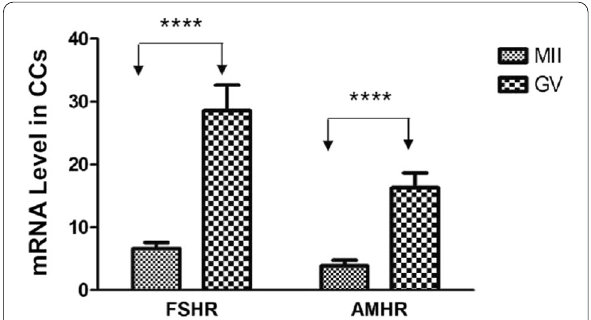
Fig. 1 The gene expressions of FSHR and AMHR2 between MII-CCs and GV-CCs. *Indicates a significant difference in gene expression between groups (**** p < 0.0001)